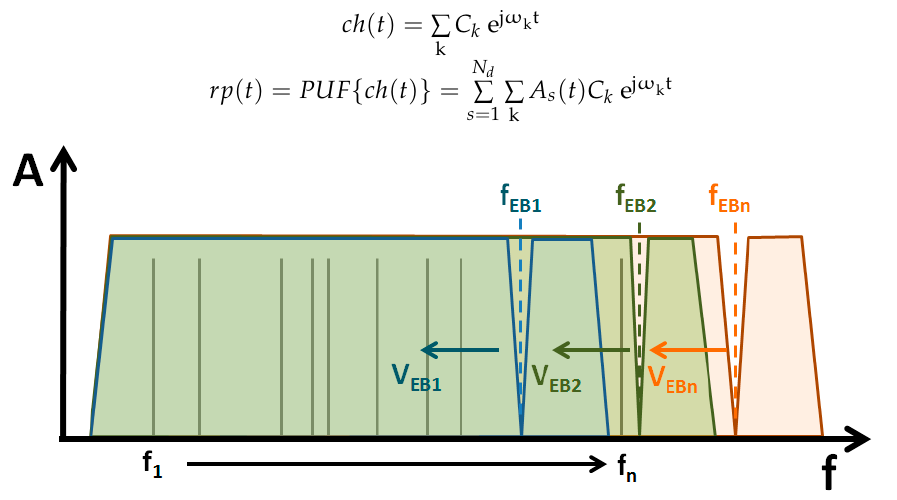
Figure 9. Operation of the complete PUF.